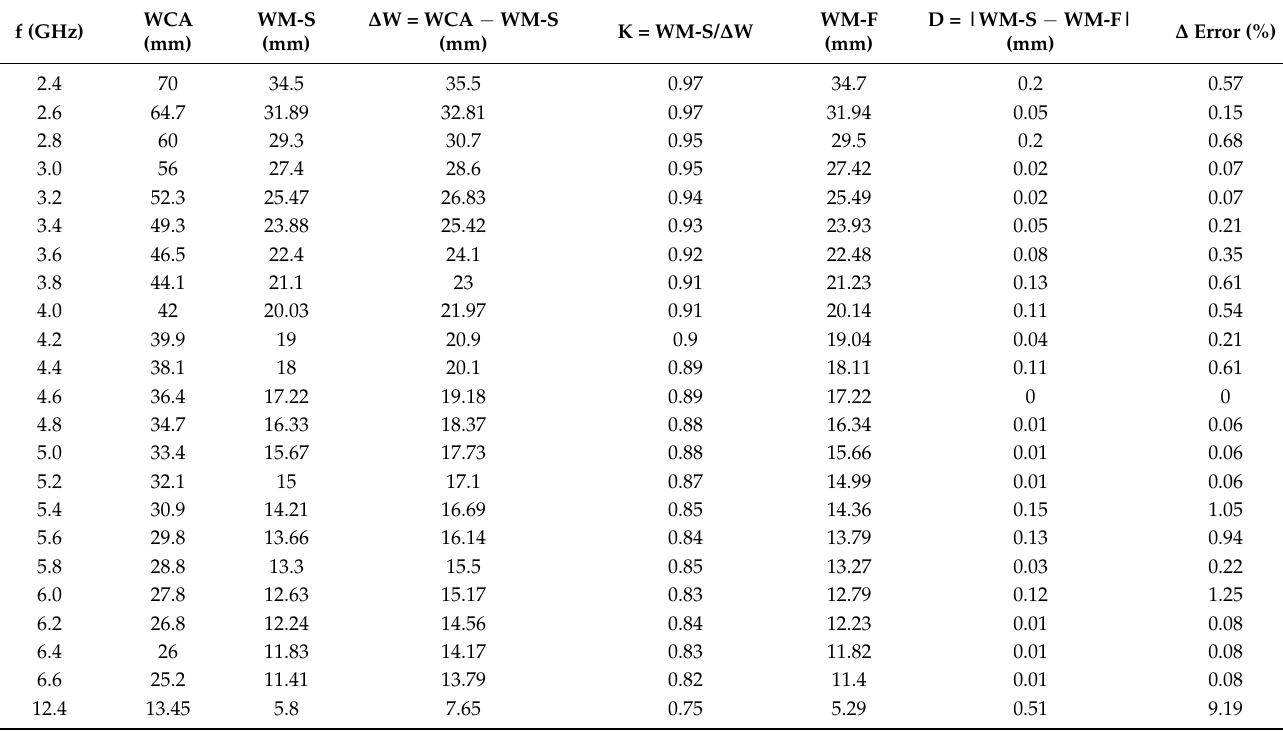
Table 4. Patch width estimation on RO4003C substrate using